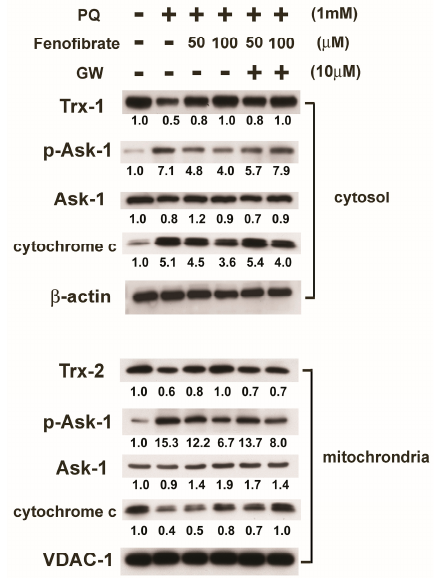
Figure 7. Effects of fenofibrate on the expression of paraquat (PQ)-induced thioredoxins (Trxs), signal-regulated kinase-1 (Ask-1), and cytochrome c assessed by western blot analysis. RF / 6A cells were pretreated with a high or low dose of fenofibrate for 1 h, then exposed to 1 mM PQ for 1 h (for phospho-Ask-1 (p-Ask-1)) or 24 h. In GW6471 (GW) treated groups, the cells were incubated with 10 µ M GW6471 for 1 h before fenofibrate treatment. Mitochondrial proteins and cytosolic proteins were isolated and analyzed separately. The expression levels of mitochondrial Trx-2, Ask-1, p-Ask-1, and cytochrome c and cytosolic Trx-1, Ask-1, p-Ask-1, and cytochrome c are shown, and the fold changes compared to those in control group are presented under the protein bands. In cytosol, β -actin was used as an internal control. In mitochondria, VDAC-1 was used as an internal